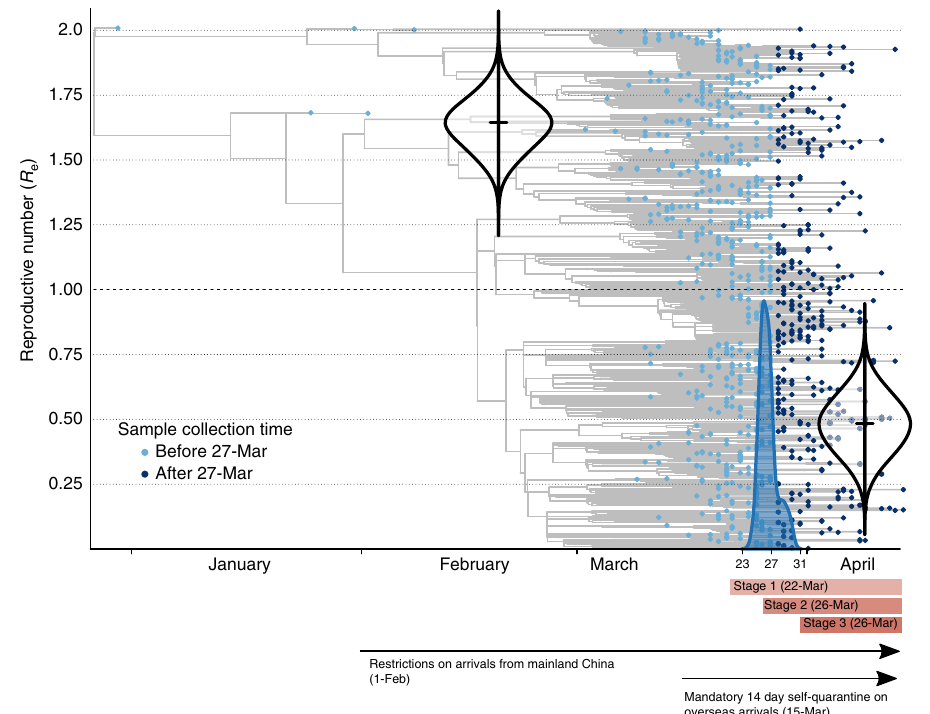
Fig. 6 Phylodynamic estimates of the reproductive number ( R e ). A birth – death skyline model was fi t, where R e is allowed to change at a single time point determined by the data. The X axis represents time, from the molecular estimate of the origin of the sampled diversity, around late December 2019 (95% credible interval, CI: 18th December to 30th December) to the date of the most recently collected genome in 13 April. The blue shows the posterior distribution of the timing of the most signi fi cant change in R e , around 27 March (CI: 23 – 31 March). The Y axis represents R e , and the violin plots show the posterior distribution of this parameter before and after the change in R e , with a mean of 1.63 (CI: 1.45 – 1.80) and 0.48 (CI:0.27 – 0.69), respectively. The phylogenetic tree in the background is a maximum clade credibility tree with the tips colored according to whether they were sampled before or